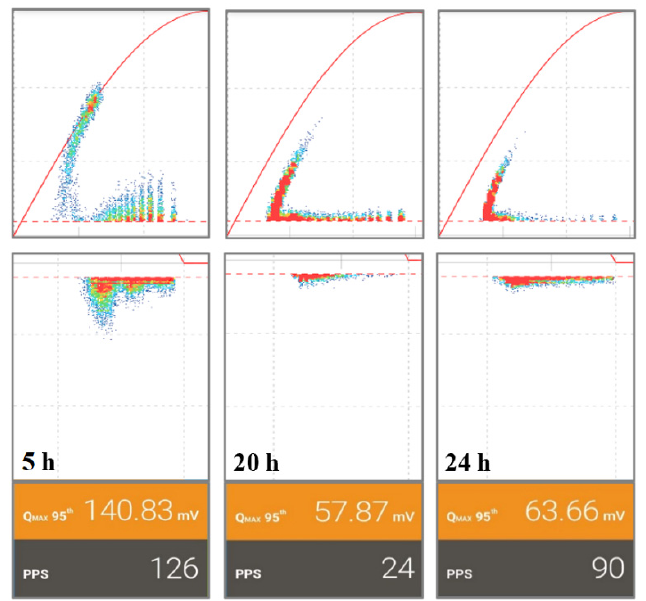
Figure 7. DCP voltage PRPD patterns with δ = 0 acquired after 5, 20 and 24 h of voltage application. To save space compared to Figure 6, the PRPD patterns positioned in the upper part are obtained during the DCP rising time, whilst those in the bottom part refer to the DCP falling time.